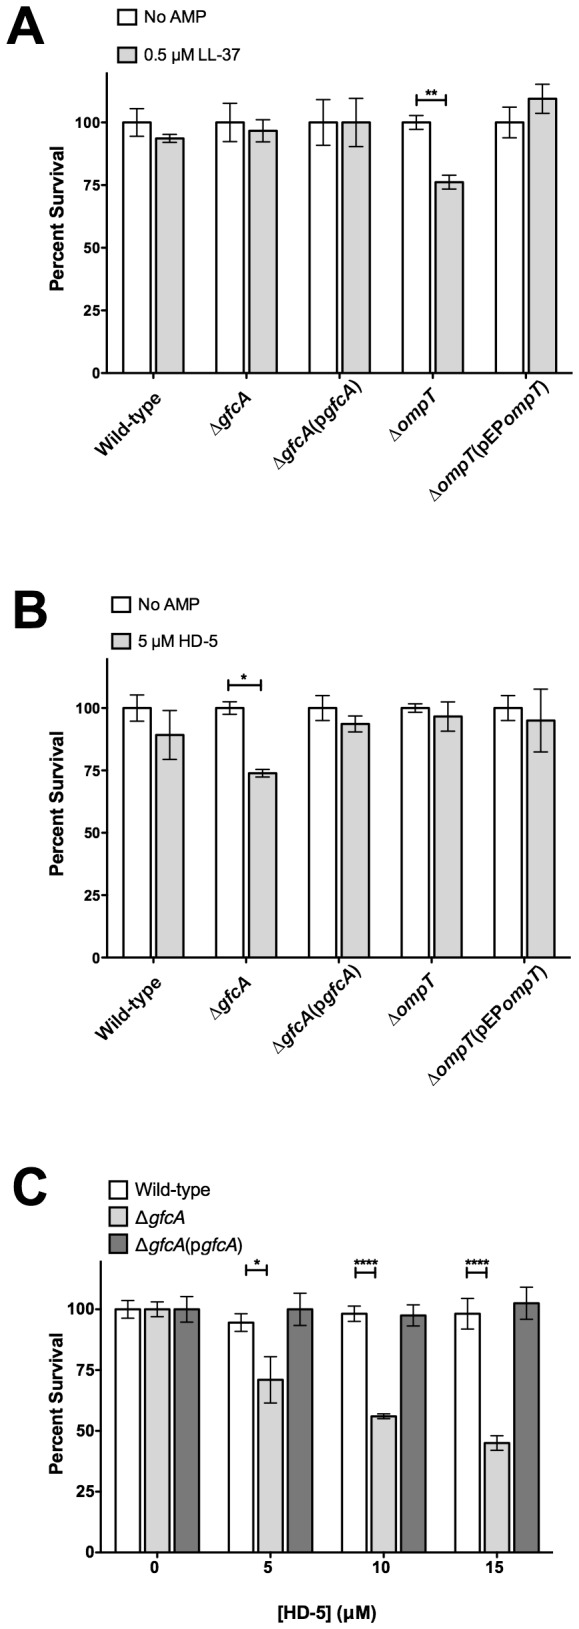
The G4C promotes resistance to HD-5.Survival of the indicated EPEC strains in the presence of LL-37 (A) or in the presence of HD-5 (B and C) at the indicated concentrations. Results are expressed as means ± SEs of triplicate samples. Data shown are representative of at least three independent experiments. Asterisks indicate statistical significance; *, P<0.05; **, P<0.01; ****, P<0.0001 by two-way ANOVA and Bonferroni’s multiple comparison post
hoc test.